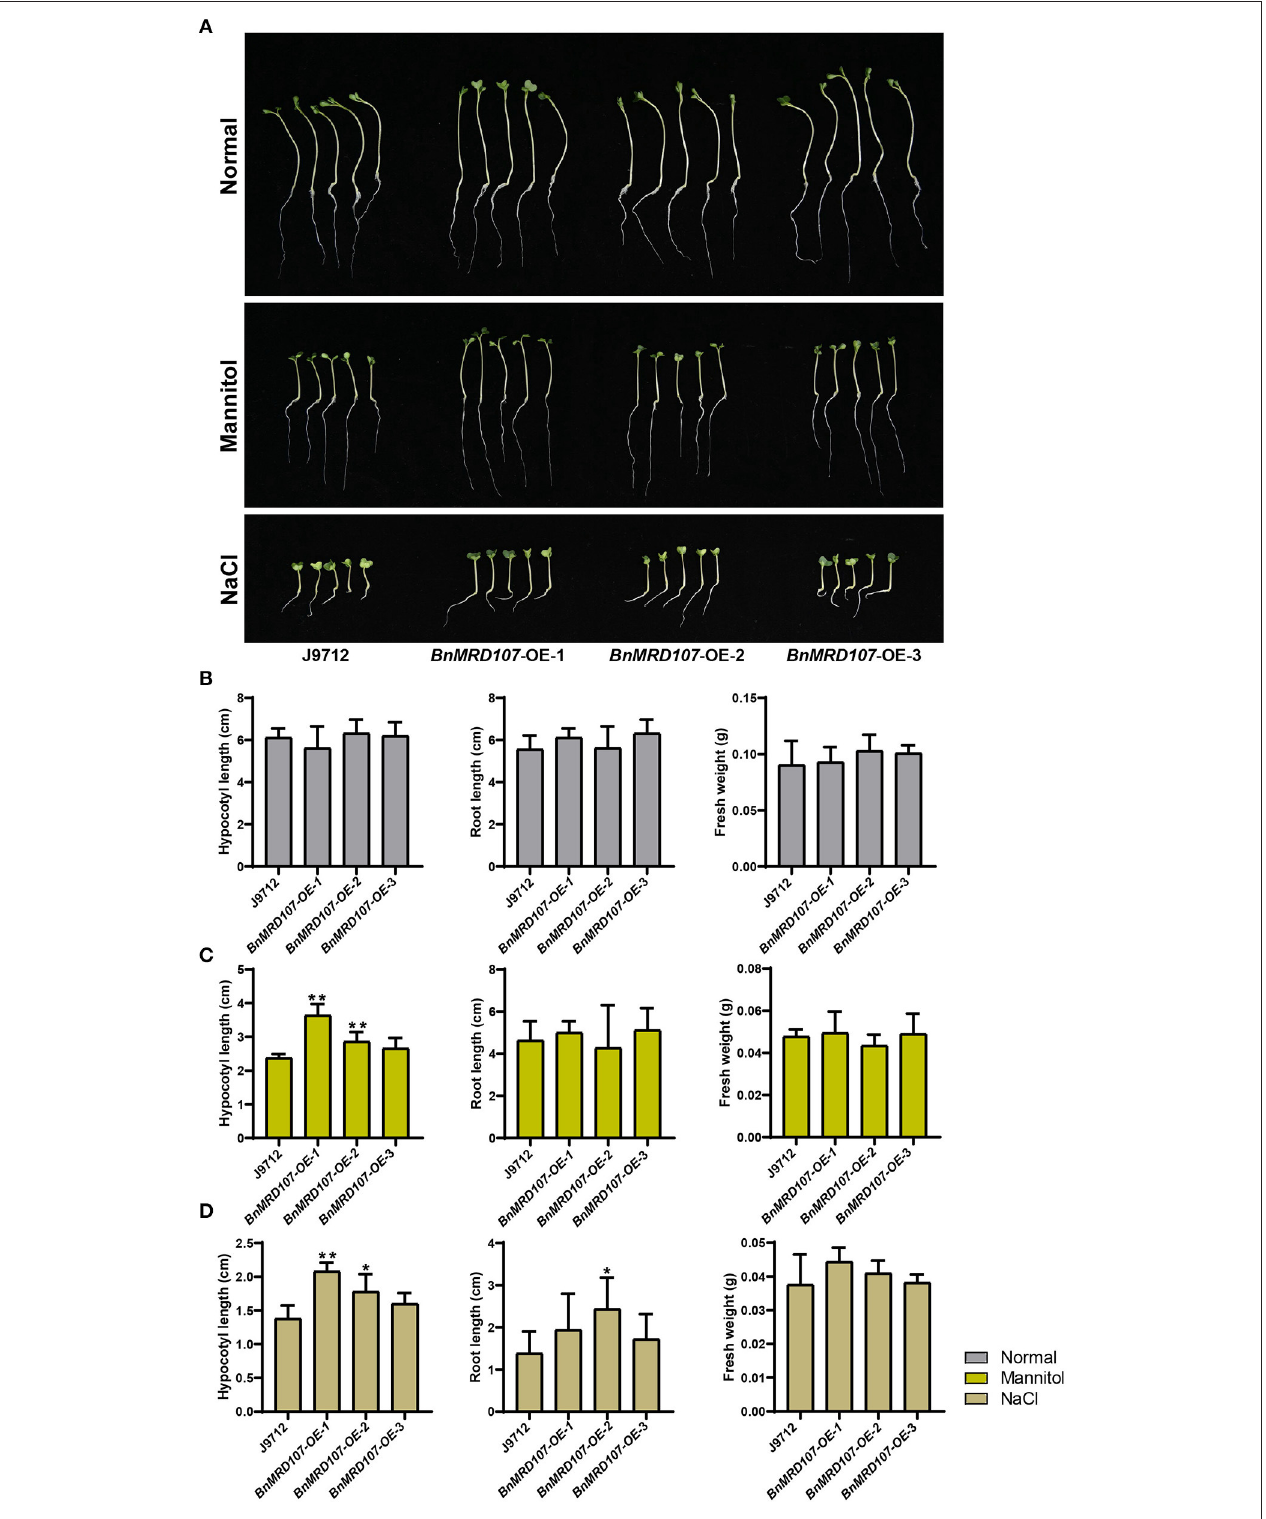
FIGURE 9 | Phenotype of BnMYBR107 -OE plants under normal conditions, osmotic stress, and salt treatments. (A) Growth performance of J9712 and BnMYBR107 -OE plants under normal conditions, osmotic stress, and salt treatments. (B–D) Hypocotyl length, root length, and fresh weight under normal conditions, osmotic stress, and salt treatments. Data are presented as means ± SD ( n = 5). Asterisks (*) indicate significant differences between the transgenic lines and J9712 based on Duncan’s multiple range test (* p < 0.05, ** p < 0.01).